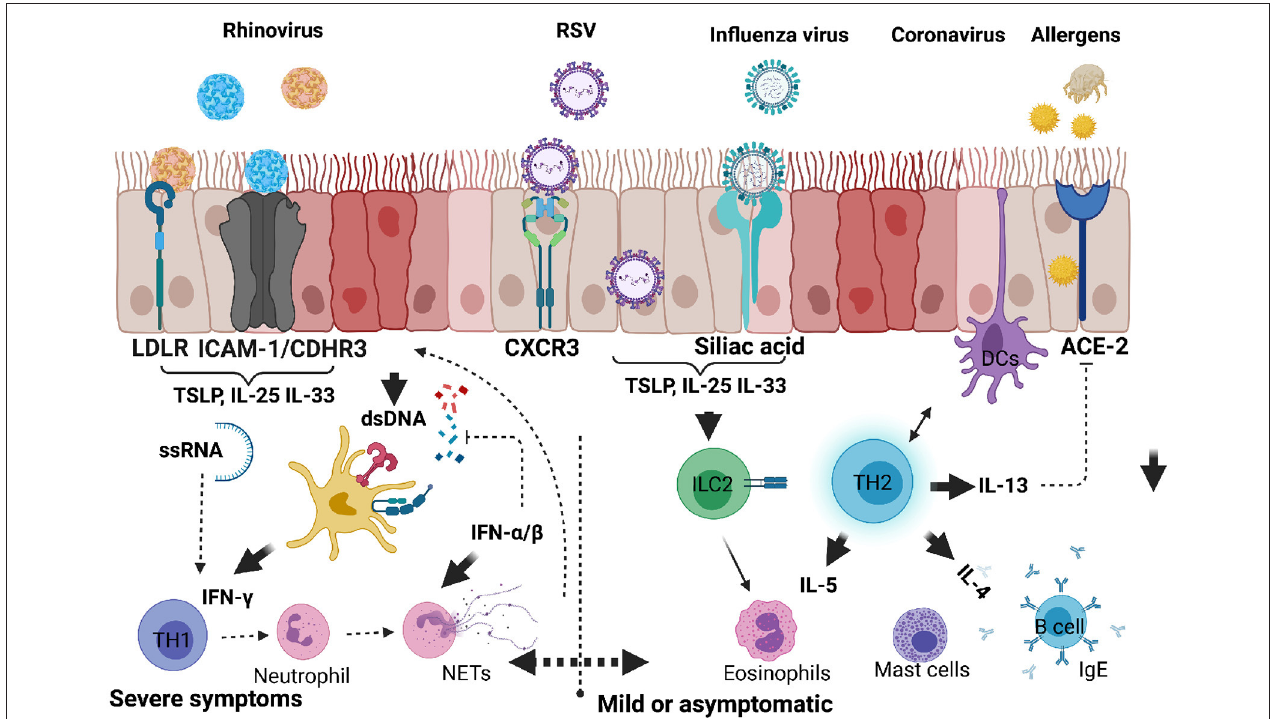
FIGURE 2 | Respiratory viruses that infect upper and lower respiratory airways causing inflammatory response and exacerbating allergic asthma in children. When infectious agents such as viruses or allergens bind to their respective receptors on the surface of epithelial cells, they activate downstream signals. Upon these agents entering in asthma predisposed individuals, there is an increased tendency to produce proinflammatory cytokines such as IL-25, IL-33, or TSLP by epithelial cells. ILC2 are directly activated to produce IL-5 and IL-13, whereas TH2 cells are activated by DCs. Viral RNA or DNA can be detected by host nucleic acid receptors which help produce IFN- α / β and promote anti-viral TH1 cells producing IFN- γ . Dysregulated antiviral response can lead to neutrophil degranulation, NETosis and exacerbation of mild or moderate responses to severe form of allergic asthma. Created with